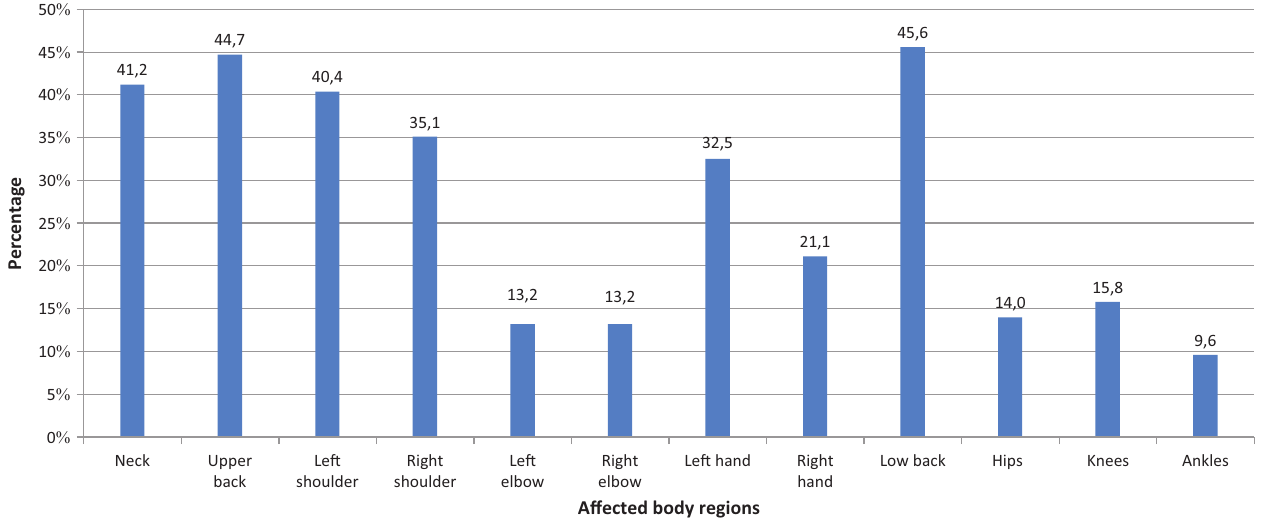
Le(cid:20) Right shoulder shoulder Le(cid:20) elbow